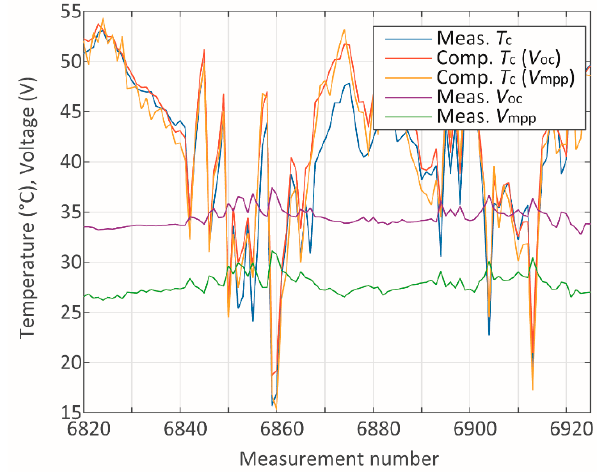
Figure 9. Temperature and voltage during cloudy days.